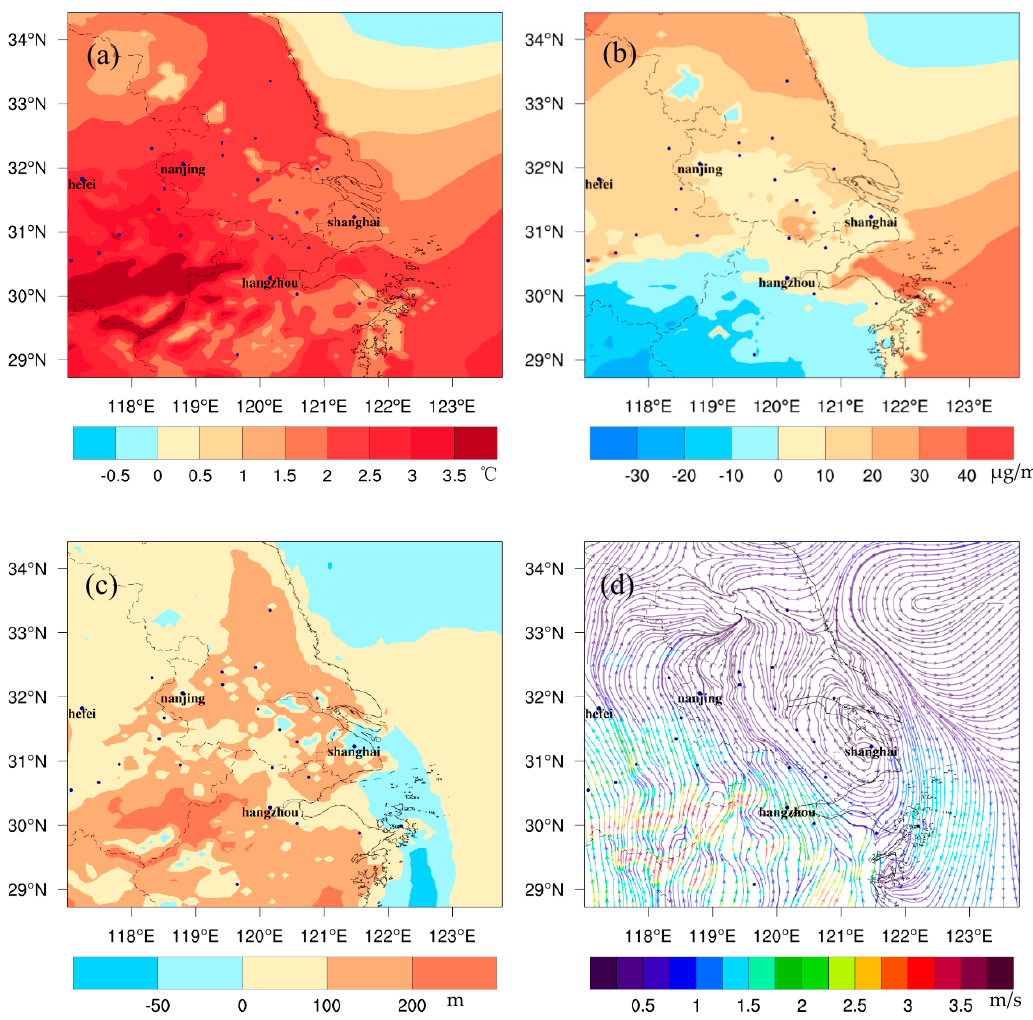
Figure 3. The spatial distribution of the monthly averaged differences of ( a ) 2-m air temperature, ( b ) 2-m absolute humidity, ( c ) planetary boundary layer height, and ( d ) wind fields between FUTMET and PREMET during the nighttime (from 19:00 to 6:00 LST).